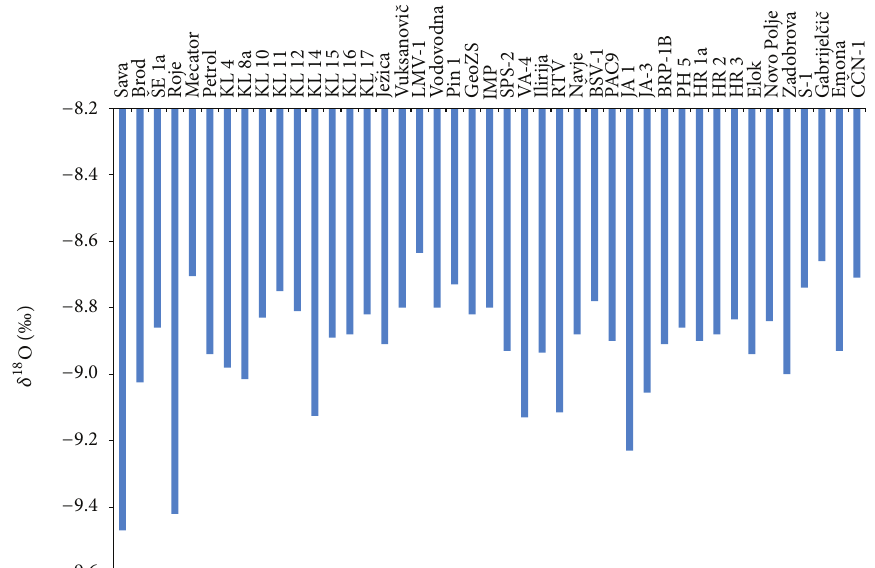
Figure 5: Isotopic composition of oxygen in groundwater of Ljubljansko polje aquifer.